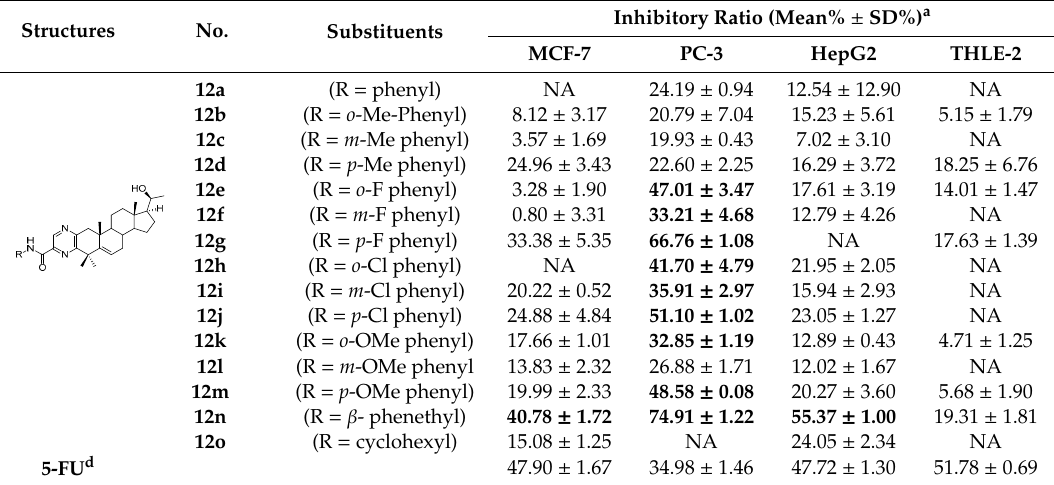
Table 2. IC 50 of the derivatives 12g and 12n with PC-3 and THLE-2 cell